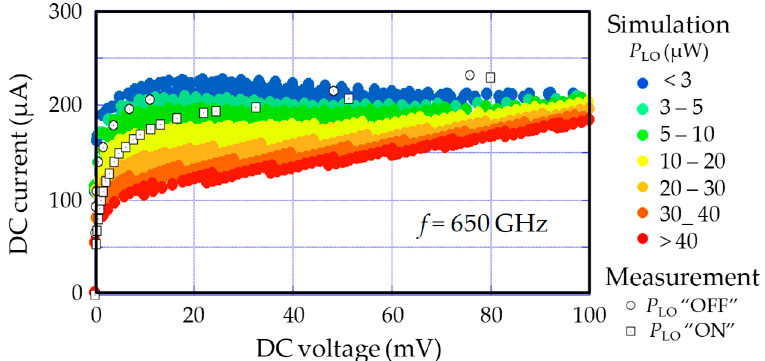
Figure 13. For a YBCO HEB, I - V map, with P LO levels, from our simulation with 650 GHz RF current (non-uniform LO power dissipation). Measurement points, without and with LO power applied at the same frequency, are also indicated (courtesy J. Raasch [48]).